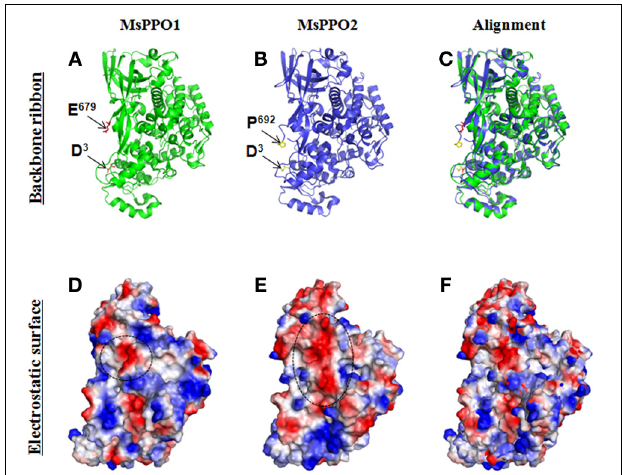
FIGURE 2 | Electrostatic surfaces of MsPPO1 and MsPPO2. Crystal structures of two Manduca sexta PPOs (PDB ID code 3HHS) were aligned using the PyMOL Molecular Graphics System (http://pymol.org/). (A–C) Secondary structure (Backbone ribbons) of two M. sexta PPOs. PPO1 crystal structure (A) . The N-terminus residue is D 3 , and C-terminus residue is E 679 as indicated by arrows. PPO2 crystal structure (B) . The N-terminus residue is D 3 , and C-terminus residue is E 692 as indicated by arrows. (C) . Alignment of PPO1 and PPO2 at the same angle. (D,E) The electrostatic surfaces of two M. sexta PPOs after being generated using the PyMOL software. The backbone ribbons and electrostatic surfaces of each PPO are surveyed from the same view. Red is negative, and blue is positive. MsPPO1 (D) and MsPPO2 (E) have different surface electrical charges. In (D) , the circled negative area is composed of I 97 D 98 , A 221 D 222 residues. In (E) , the circled negative area is composed of N 97 E 98 , D 101 , S 225 A 226 S 227 , E 229 , V 232 , S 355 V 356 L 357 residues. (F) . Alignment of PPO1 and PPO2 at the same